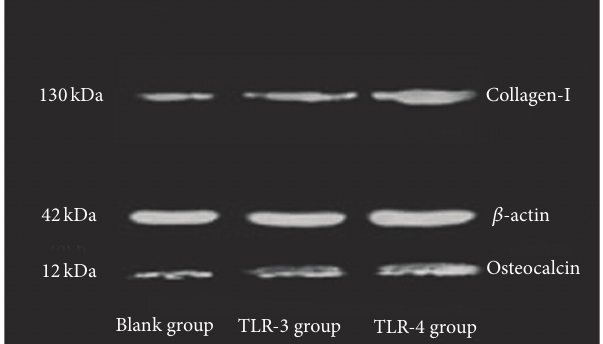
Figure 2: Western blotting of collagen-I and osteocalcin. BMSCs stimulation by different TLR ligands affected secretion of collagen-I and osteocalcin. The amount of collagen-I and osteocalcin was assessed by Western blotting analysis. Compared with BMSCs untreated which were used as negative control, cells stimulated by TLR-3 ligands and TLR-4 ligands secreted more collagen-I and osteocalcin (𝑛 = 12) . The effect of TLR-4 ligands was stronger than TLR-3